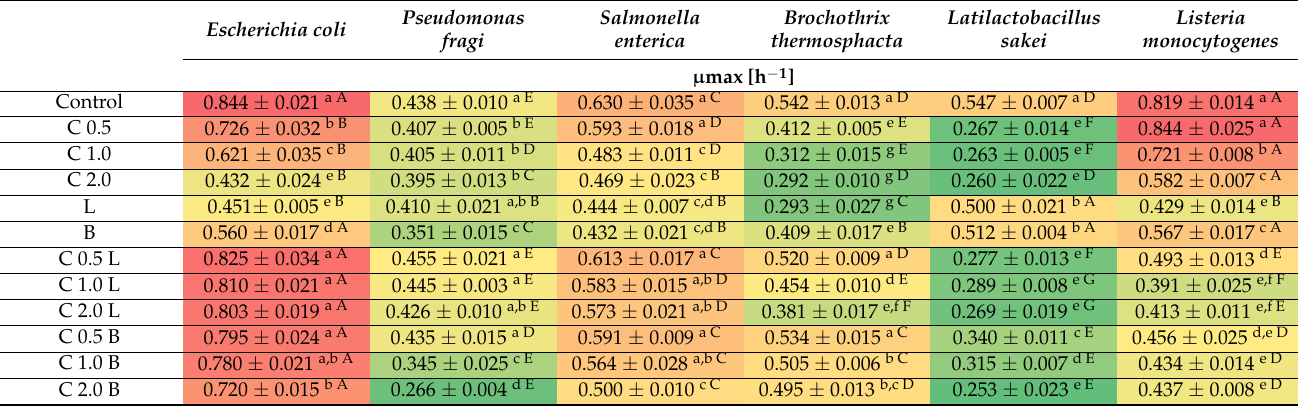
Table 4. Effects of C. incanus extract and dyes on the maximum specific growth rate ( µ max) of bacteria (mean ± SD, n =